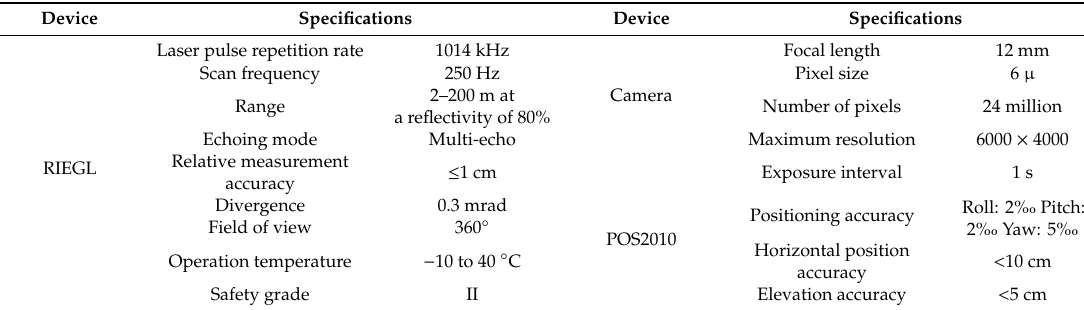
Table 1. A RIEGL VUX-1HA laser sensor with the following specifications is used in the customized mobile-scanning system mentioned: laser pulse repetition-rate = 1014 kHz, scan frequency (number of laser lines recorded per second) = 250 Hz, and measuring range = 2–200 m at a reflectivity of 80%. A SONY A7 camera, with a focal length of 12 mm, pixel size of 6 µ m, and image size of 24 million pixels, is used. The POS2010 inertial navigation system (Beijing) [3] is used. Table 1. Device